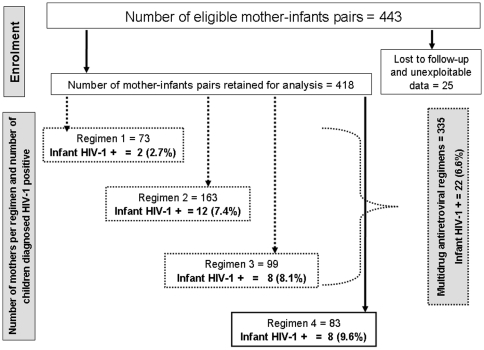
Flowchart describing regimens received and MTCT rates at six weeks at the CNPS, Cameroon.Between October 2004 and March 2008, 443 mother-infant pairs were eligible for the study. Among these, 25 had unexploitable data and 418 were retained for analysis.